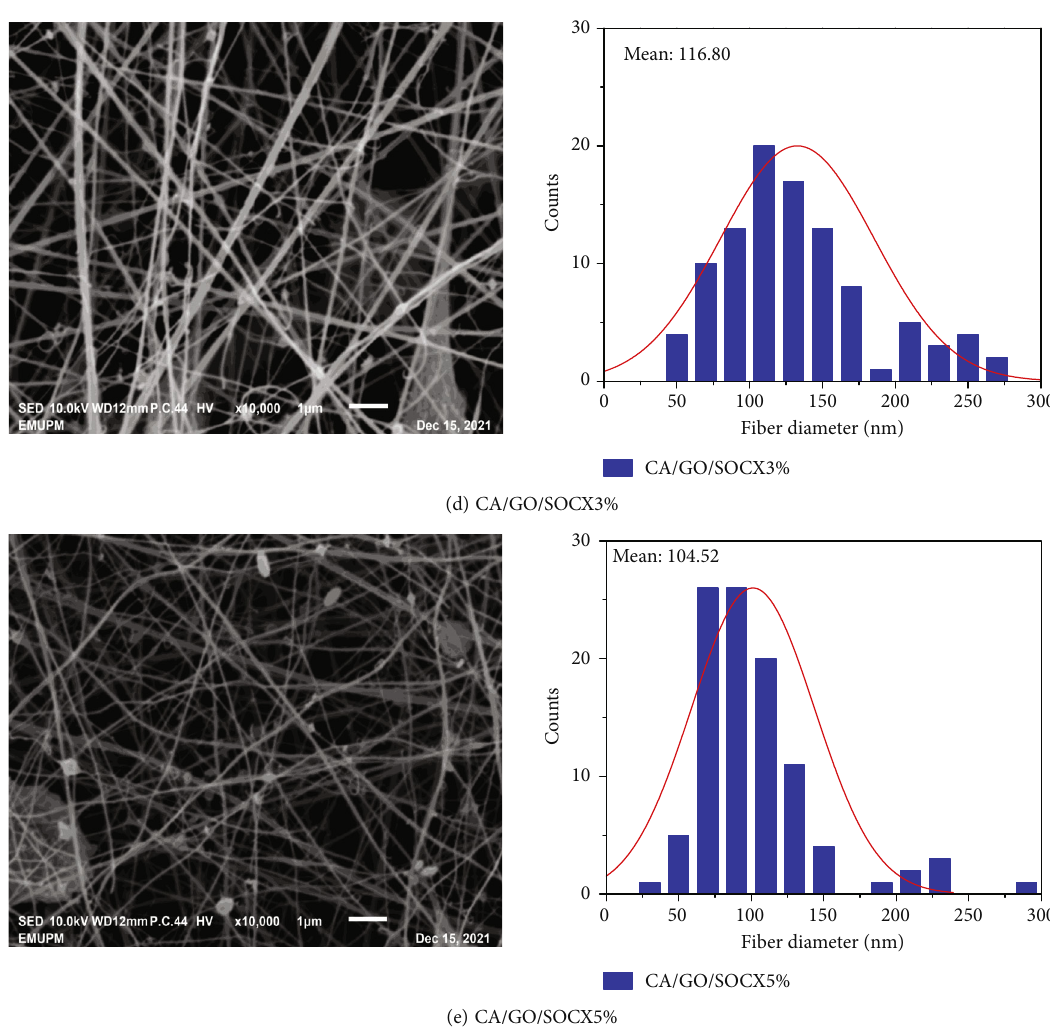
Figure 4: SEM micrograph of (a) CA nano fi ber and (b) CA functionalized GO nano fi ber, CA functionalized GO with (c) 1% p-SOCX, (d) 3% p-SOCX, and (e) 5% p-SOCX. 10000X magni fi